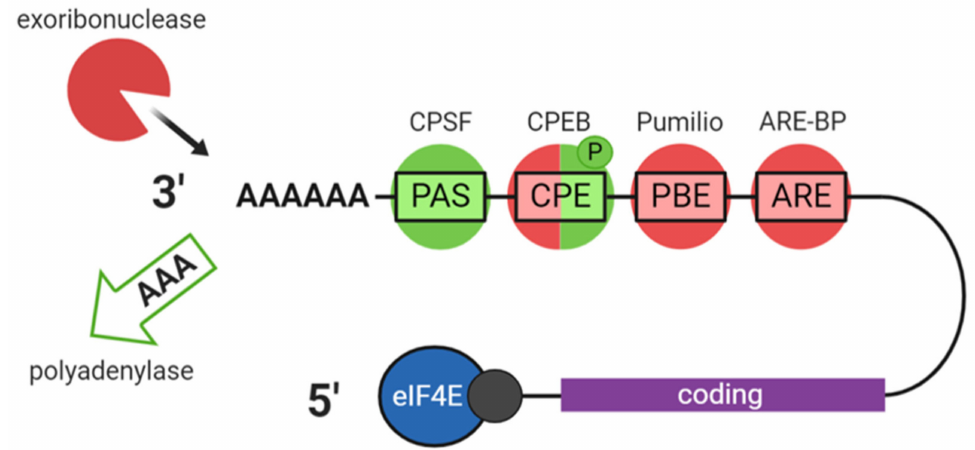
Figure 5. Key 3 (cid:48) UTR elements, their associated RBPs, and control of poly(A) tail length. 3 (cid:48) UTR elements and RBPs mediating polyadenylation and translation activation are shown in green and those mediating deadenylation and translational repression in red. PAS: Polyadenylation signal, CPSF: Cleavage and polyadenylation specificity factor, CPE: Cytoplasmic polyadenylation element, CPEB (CPEB1): CPE-binding protein, PBE: Pumilio-binding element, ARE: AU-rich element, ARE-BP: ARE-binding